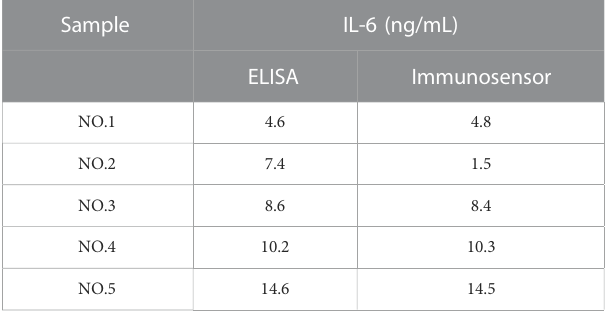
TABLE 1 Comparative evaluation of the immunosensor with ELISA.